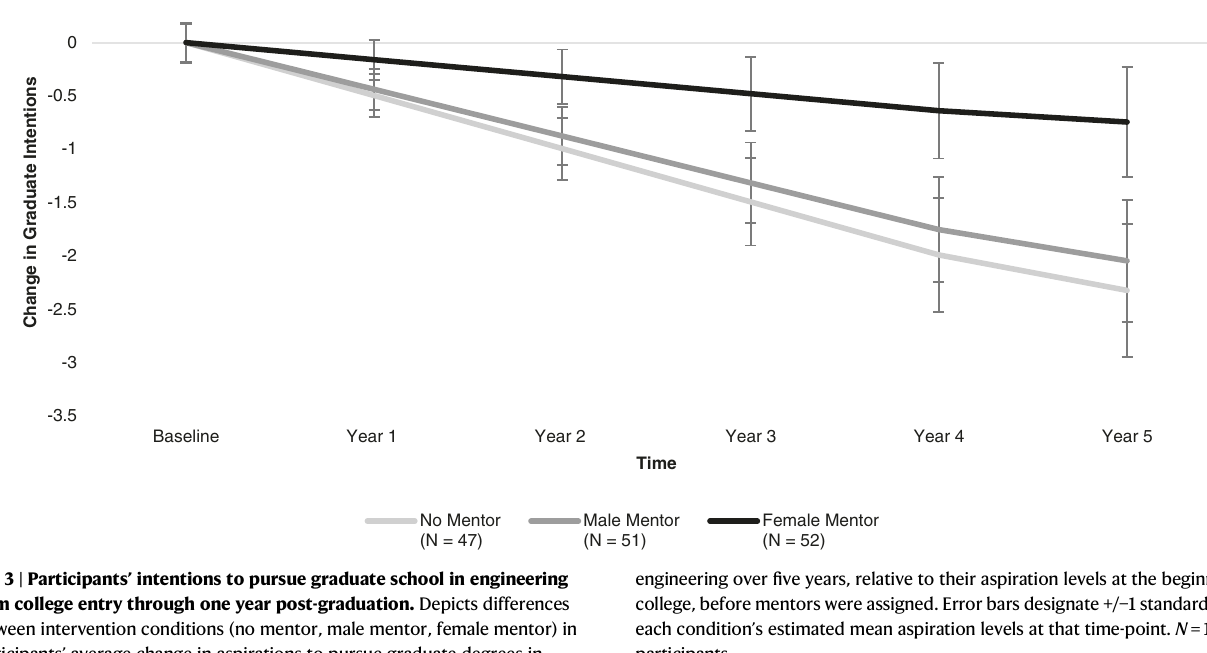
engineering over fi ve years, relative to their aspiration levels at the beginning of college, beforementorswereassigned. Error bars designate +/ − 1 standard error of each condition ’ s estimated mean aspiration levels at that time-point. N =150 participants.